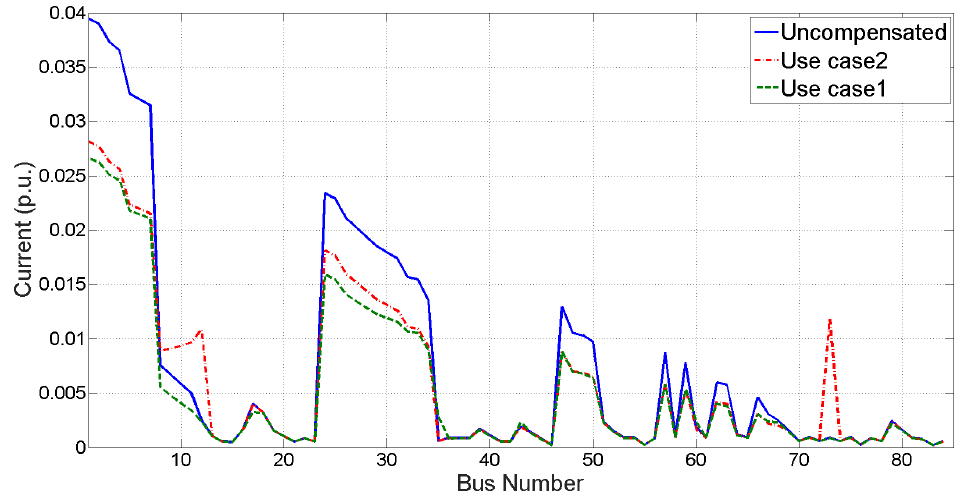
Figure 9. Line flow for N 2 in CS 1